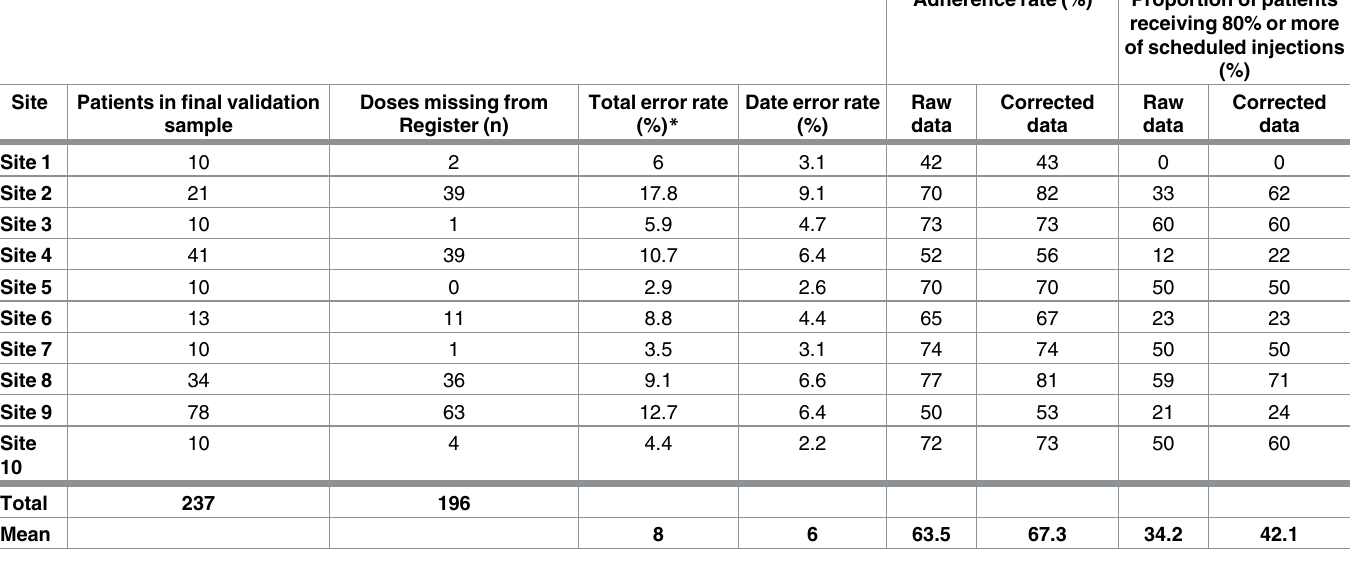
Table 1. Adherence before and after validation.